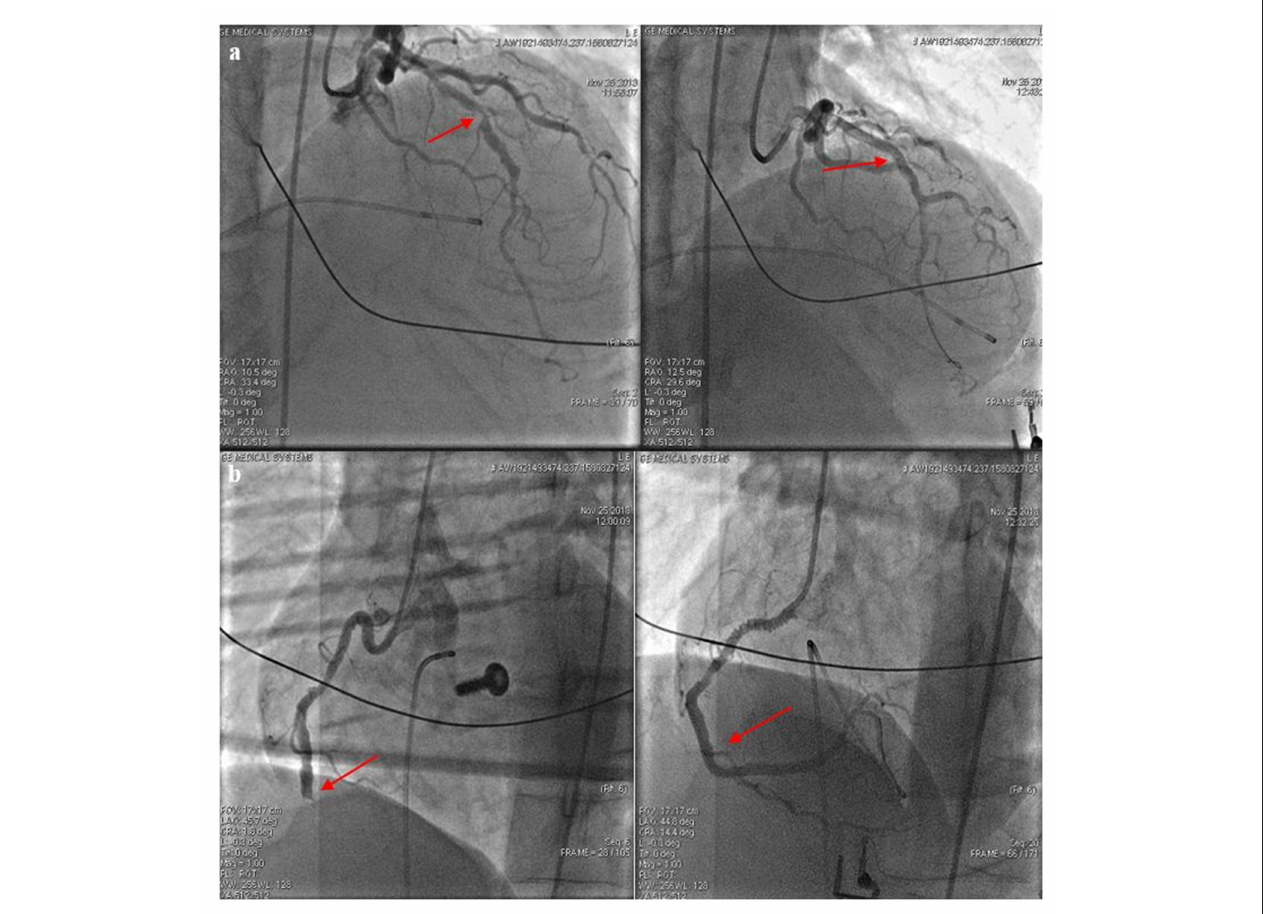
FIGURE 1 | (a) The left anterior descending artery (LAD) before and after stent implantation. After predilation at 14 atm, a 3.5 × 30mm Integrity stent was positioned into the stenosis of the LAD. Red arrows indicate the sites of intervention. Images taken before (left picture) and after (right picture) the intervention. (b) The right coronary artery (RCA) before and after stent implantation. During the intervention, a dissection developed at the extremely tortuous ostium of the RCA; to this site a 3.5 × 24mm Omega stent was placed after predilation at 15 atm (marked with right arrow). A 3.5 × 12mm Omega stent was implanted to the distal area resulting in a Thrombolysis In Myocardial Infarction (TIMI) grade 3